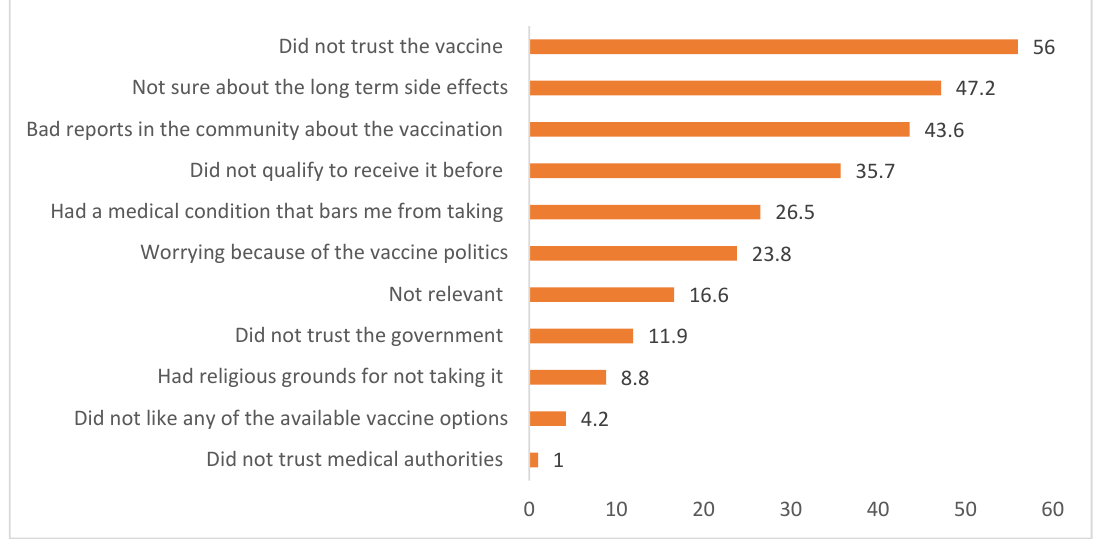
Figure 4. Reasons for vaccine hesitancy among unvaccinated individuals during COVID-19 hesitancy survey, Ethiopia, 2022.